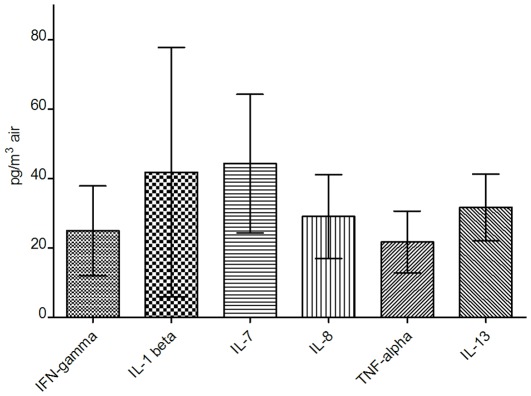
Estimated airborne concentrations of six human cytokines produced in single-pass aerosol chamber.Data shown for estimated expected airborne concentrations (pg/m3 air) of six different human cytokines as calculated by Equation 1 (N = 2; 95% CI).